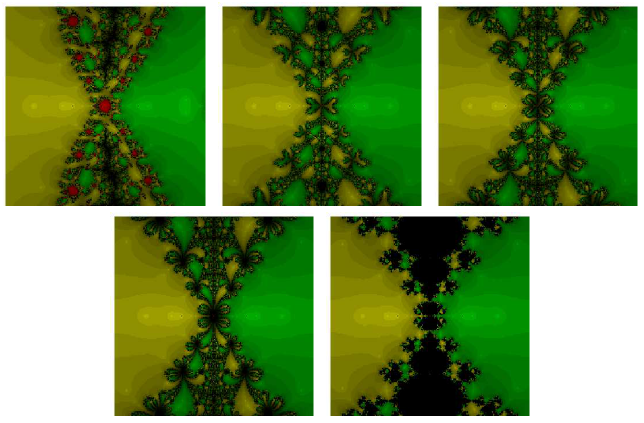
Figure 10. The basins of attraction for OM 4 , LM 4 , SSM 4 , ZM 4 and SM 4 , from left to right and top to bottom, respectively in Problem